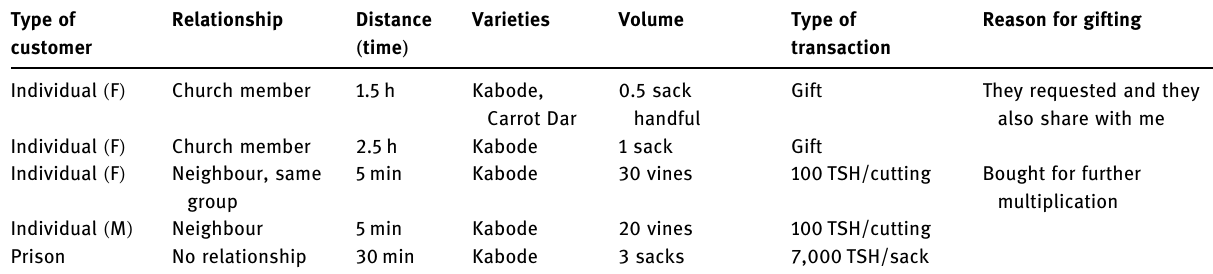
Table 5: Example of customers and associated transactions for one individual female vine seller, Lake Zone, Tanzania, 2017 – 2018 Type of